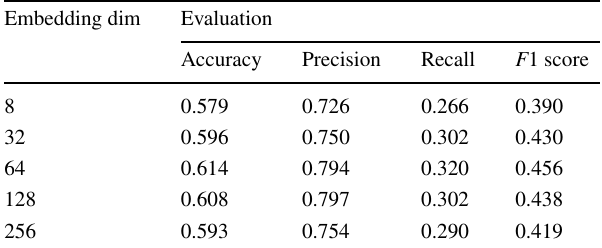
Table 5 Prediction performance of BGAM under different